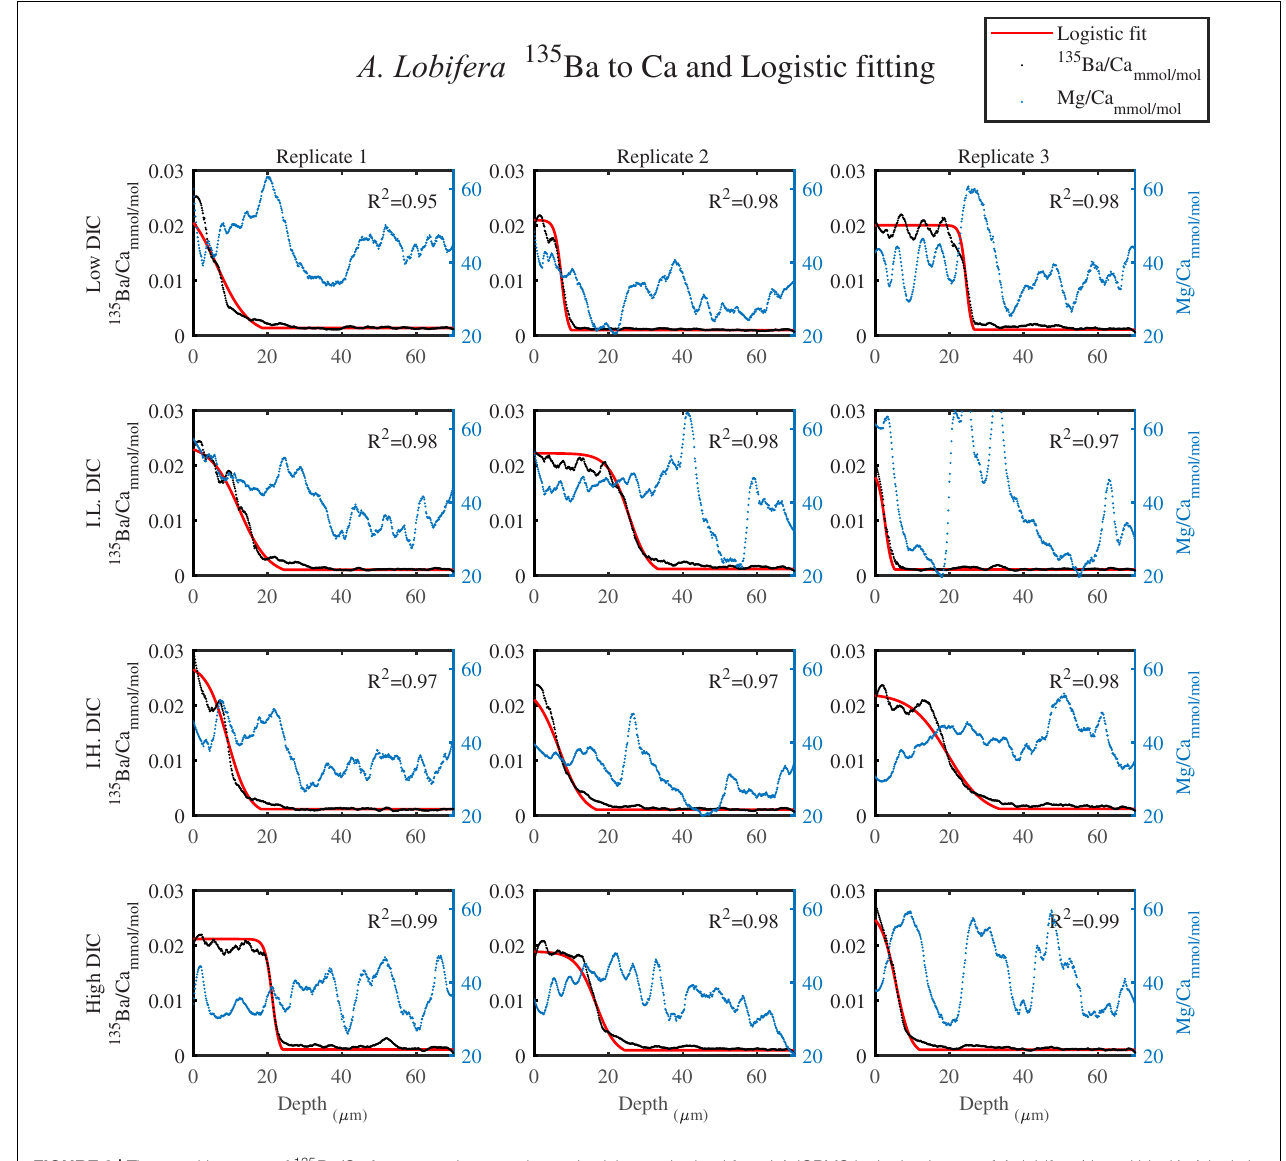
FIGURE 3 | The transition zone of 135 Ba/Ca from natural to experimental calcite as obtained from LA-ICPMS in the knob area of A. lobifera (dotted black). A logistic function was fitted to the data (red solid line). The correlation coefficients of the fitted lines are very high ( R 2 > 0.9). The dotted blue line is the Mg/Ca ratios and the high peaks represent new chambers growth. Note that there is no correlation between the newly grown calcite (high 135 Ba) and the experimental DIC